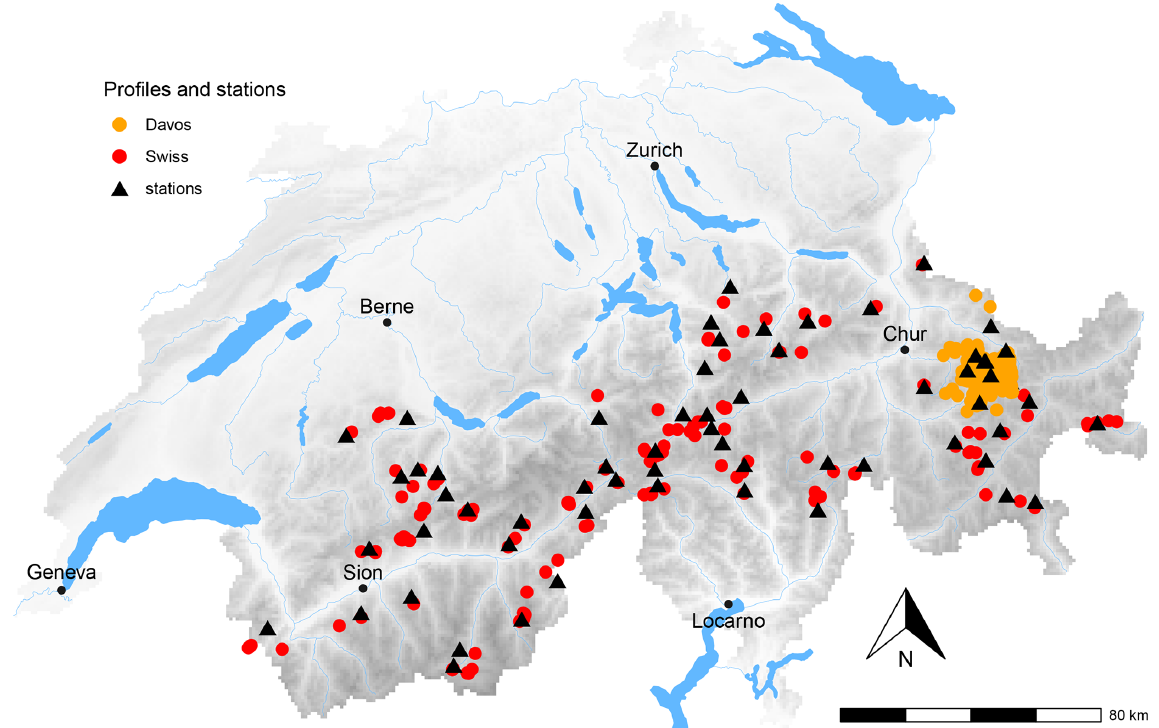
Figure A1. Map of Switzerland showing the locations of the snow profiles and the automatic weather stations used in the Davos and Swiss data set (orange and red markers, respectively). An enlargement of the Davos region is shown in Fig. A2.